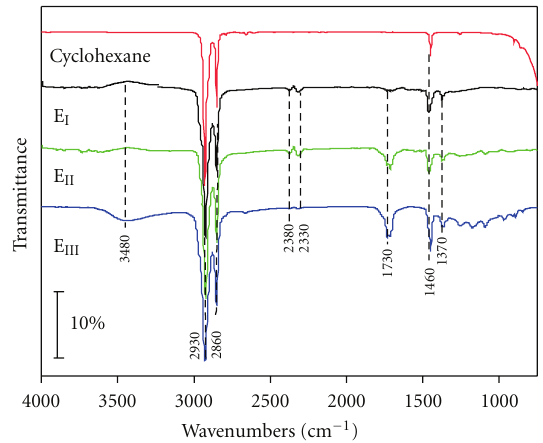
Figure 3: FTIR spectra of cyclohexane and DVR oxidized before and